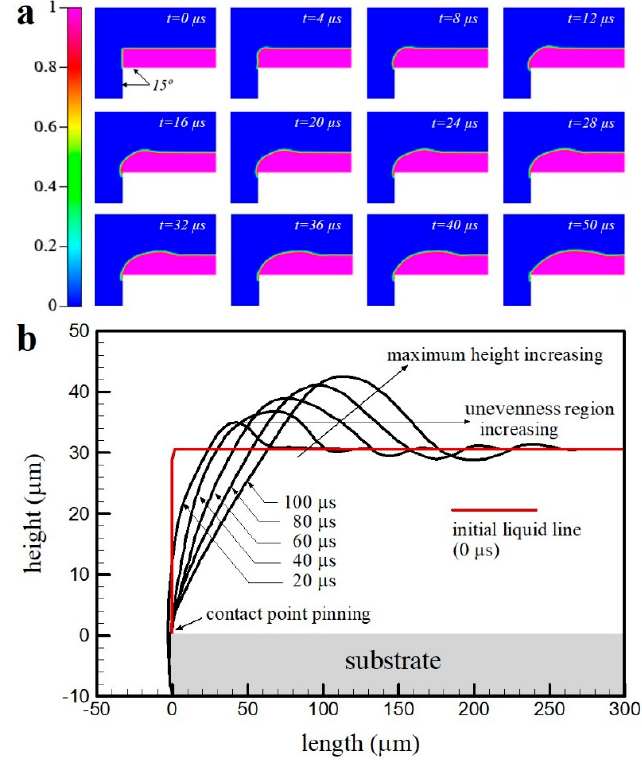
Figure 3. ( a ) Coating fluid behavior over time at the edge of the substrate under the same wetting condition of 15°. ( b ) Surface profile under the same wetting condition of 15°.